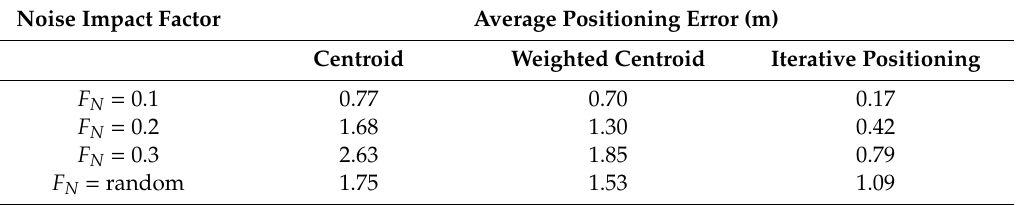
Table 1. Positioning errors of three positioning algorithms in the case of different noise impact factors.